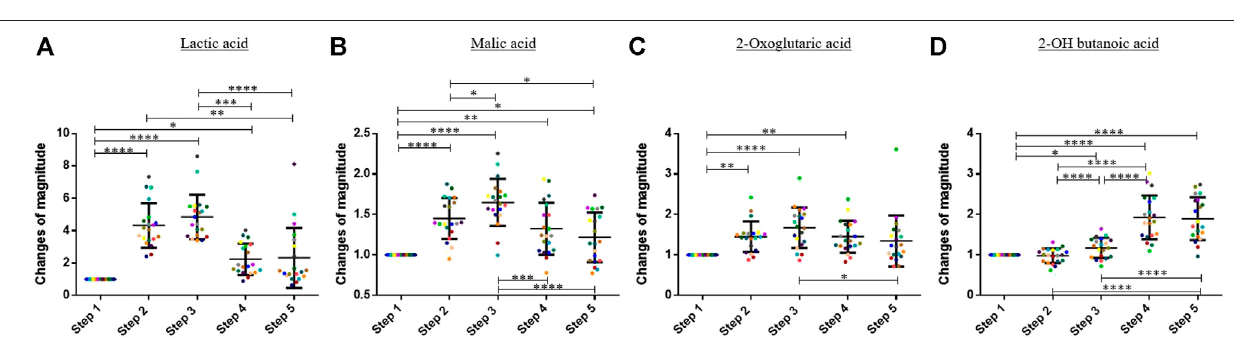
( Figure 3 ). On average, the blood concentration of lactic acid, malic acid, and 2-oxoglutaric acid increased by factors 4.86, 1.65, and 1.67 between step 1 and step 3, respectively. A Friedman test